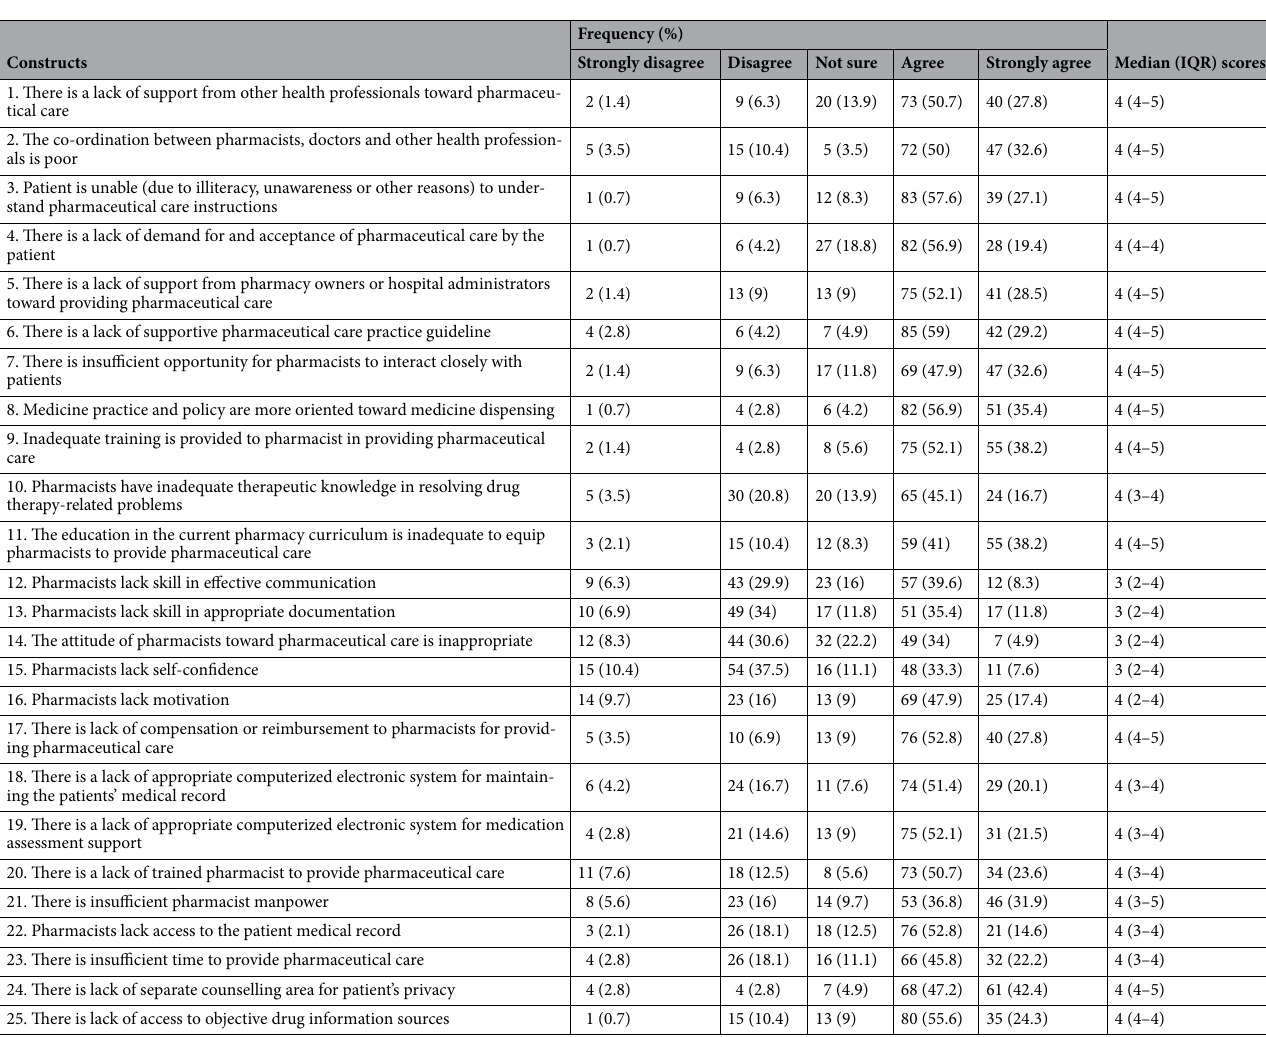
Table 7. Constructs related to barriers in providing pharmaceutical care (n: 144). DTRPs drug therapy-related problems, PC pharmaceutical